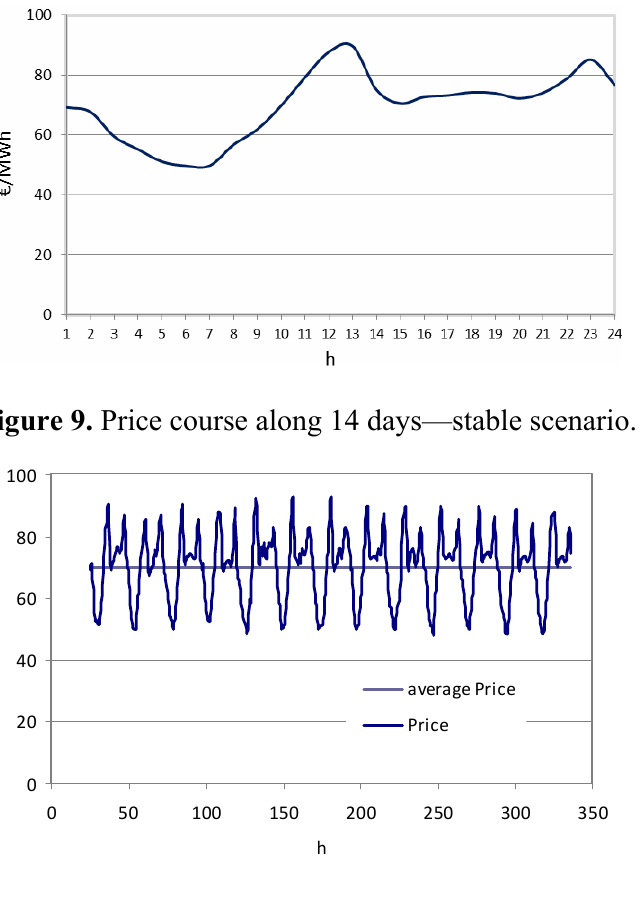
Figure 8. Daily energy price trend function.